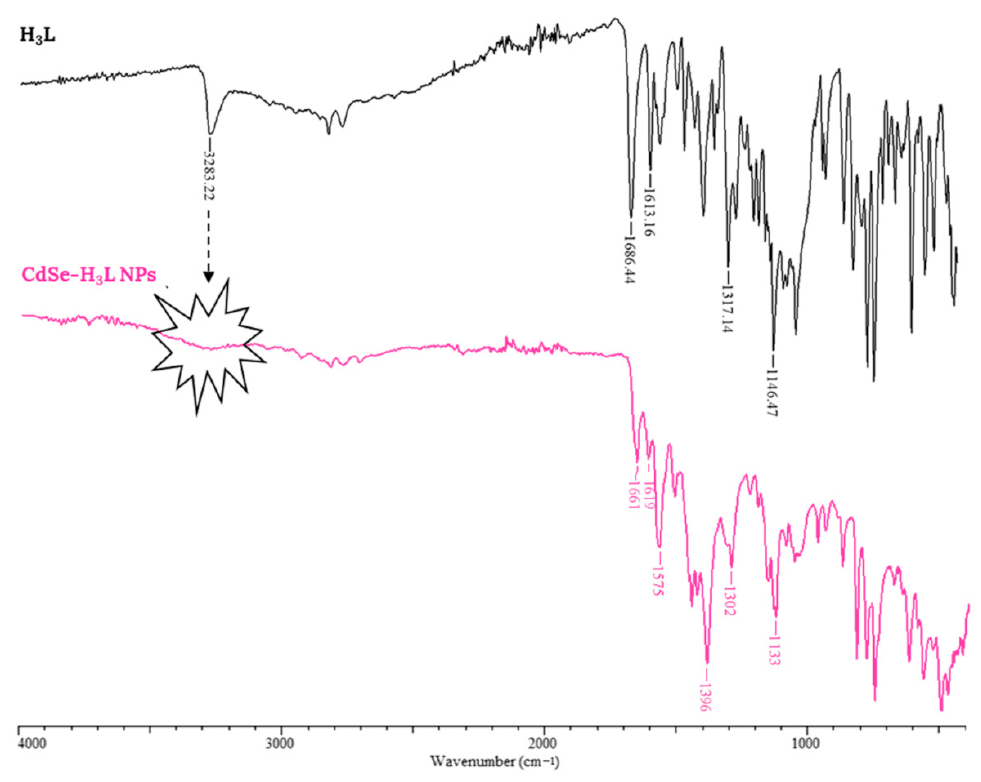
Figure 10. ATR-IR spectra of H 3 L ( top ) and CdSe-H 3 L NPs ( bottom ).